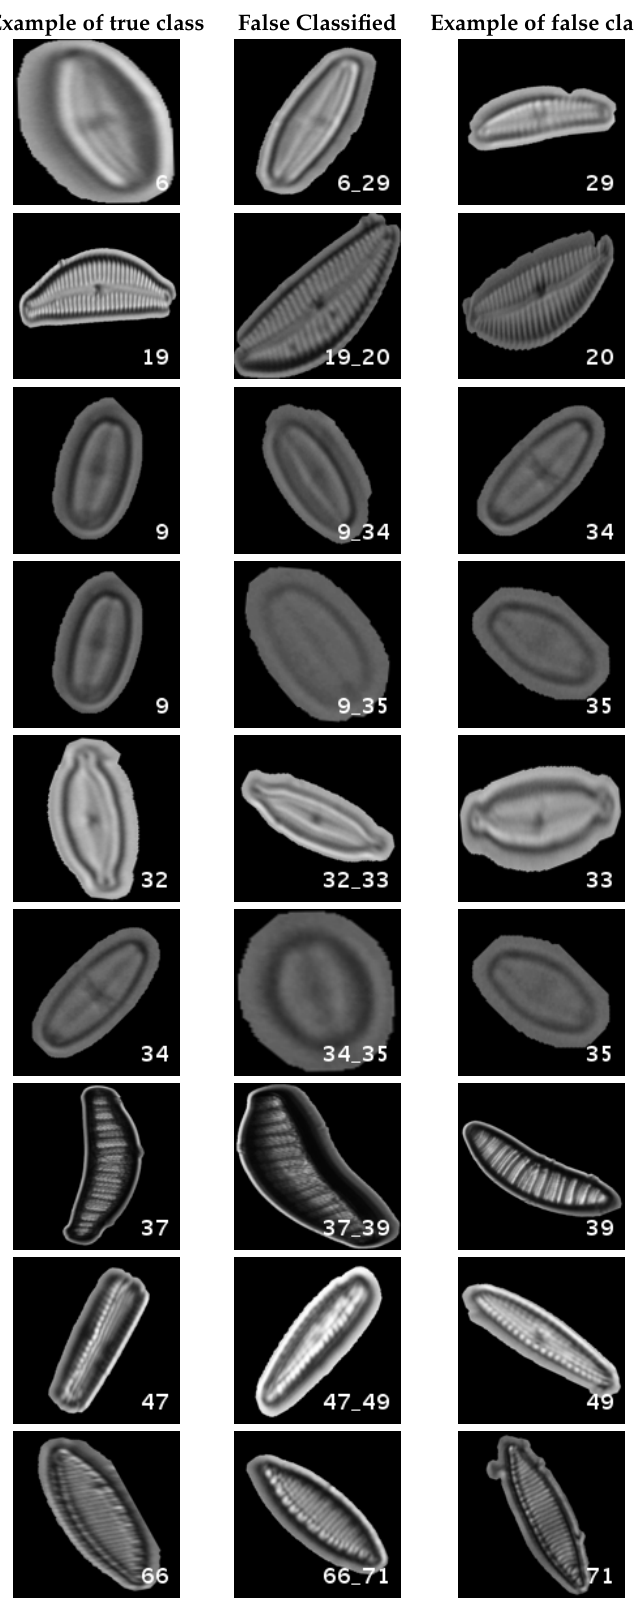
Figure 12. Segmented dataset main confusions. Each row shows an example of the true species, a missclassifed sample between two species and a sample of the second one are